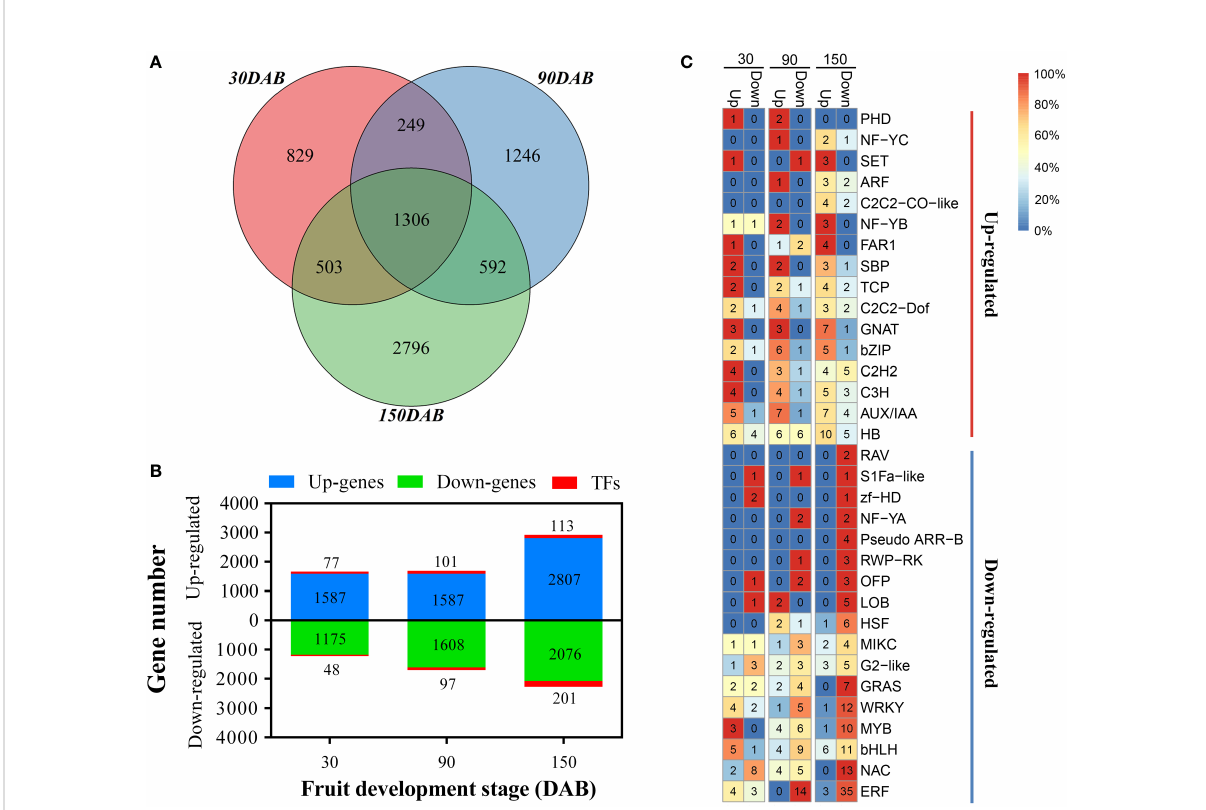
FIGURE 3 Differentially expressed genes between ‘ HanFu ’ and ‘ Huahong ’ at three stages of fruit development. (A) A Venn diagram showing the number of differentially expressed genes (DEGs) at the three stages of fruit development. (B) A histogram showing the number of up-regulated and down- regulated DEGs and transcription factors (TFs). (C) A heatmap showing the number and percentage (color) of up- and down-regulated TFs belonging to different